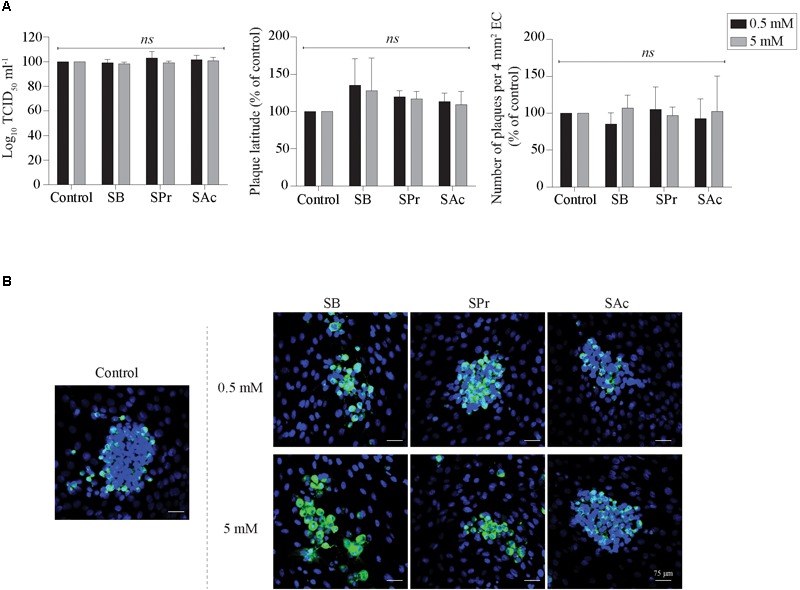
Analysis of SCFA pretreatment on EHV1 infection of equine EC. (A) Extracellular virus titer (left), viral plaque latitudes (middle), and number of plaques (right) were analyzed at 24 hpi. (B) Representative confocal images of EHV1 plaques in EC are stained in green (FITC). Nuclei were counterstained in blue (Hoechst). Five ad random chosen viral plaques were analyzed. Three independent experiments were performed and data are represented as means + SD. Statistical analysis was performed: ns indicates p > 0.05.